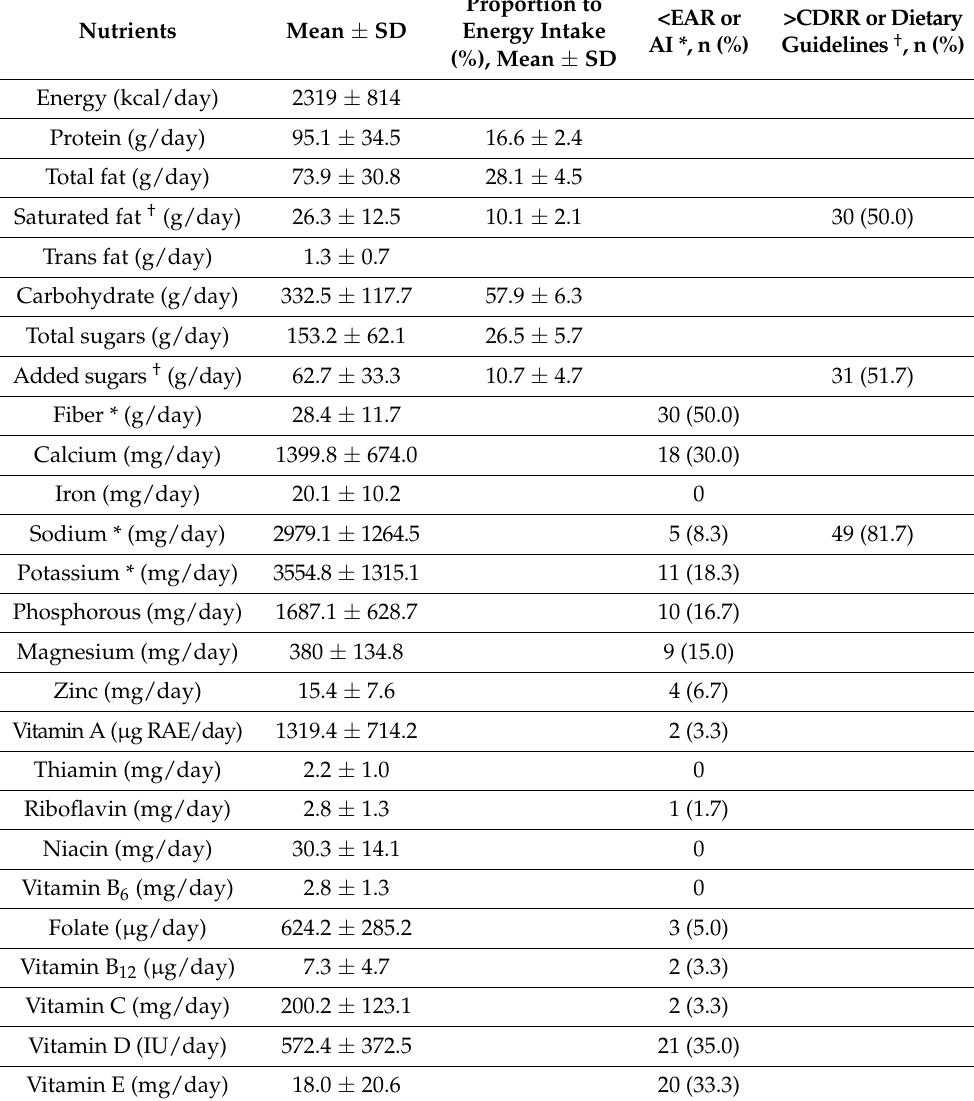
Table 2. Usual energy and nutrient intakes estimated using the Youth and Adolescent Questionnaire